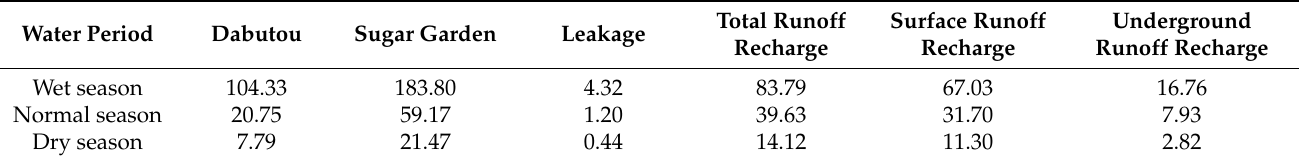
Table 3. Water balance parameters from DaButou to Sugar Garden (in m 3 · s − 1